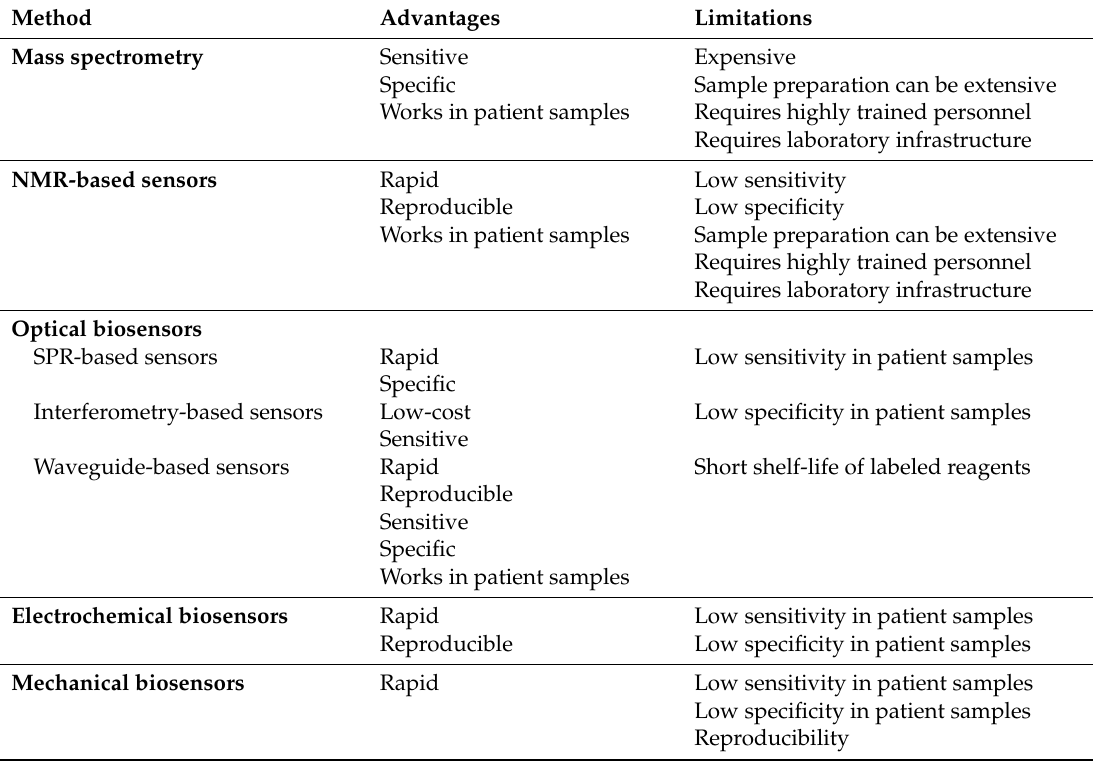
Table 1. Advantages and limitations of sensors as clinical diagnostic tools for detecting lipid and amphiphilic